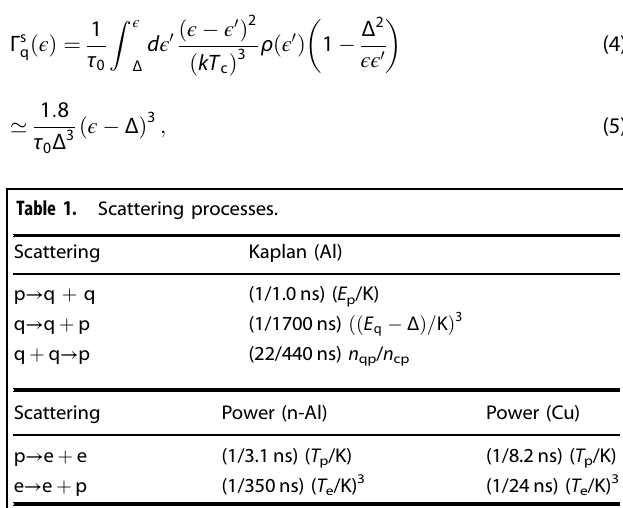
Table of scattering processes for phonons (p), electrons (e), and quasiparticles (q), with initial energies E p , E e , and E q , respectively, given in Kelvin. The “ Kaplan ” column represents the scattering rate given by ref. 27 for aluminum, using Eqs. (5), (7), and (10). The “ Power ” column is a rate from the power calculation given in Eqs. (12) and (13), for normal aluminum and copper. Both give estimates for scattering rates and their energy